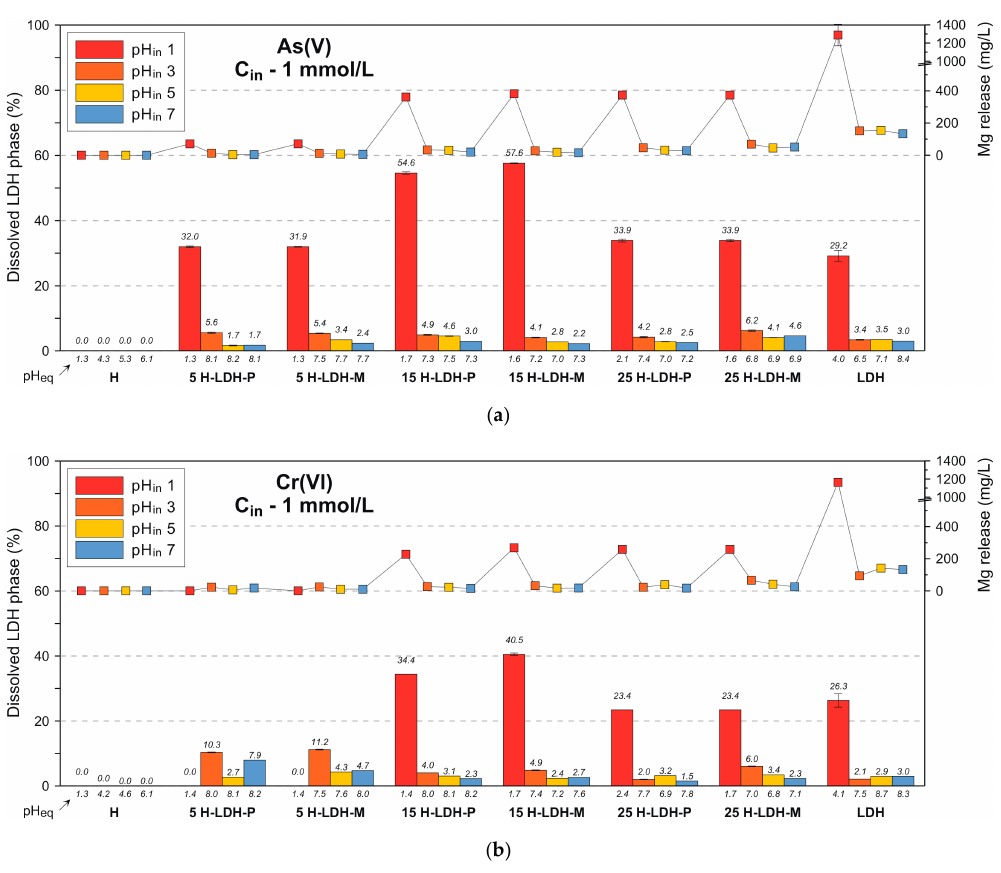
Figure 6. Mg release and percent of dissolved LDH after reaction of the adsorbents: ( a ) As(V) and ( b ) Cr(VI). Initial concentration (C in ) 1 mmol / L. Error bars may not be visible due to low discrepancy of results.